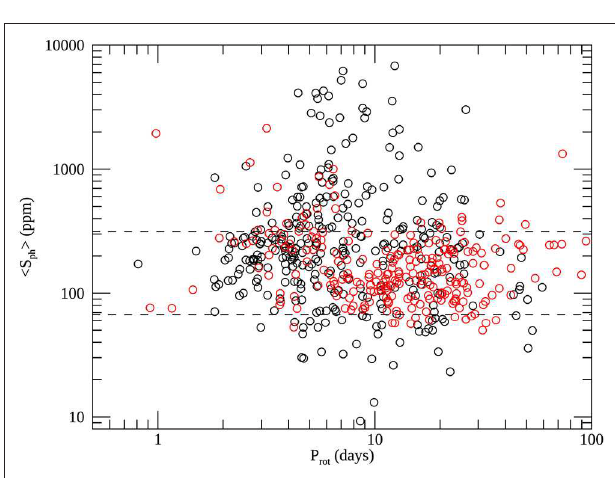
FIGURE 9 | Proxy of the magnetic activity, < S ph > as a function of the rotation period P rot for the full sample. The black symbols represent the non-oscillating stars while the red symbols represent the stars with detected oscillations from García et al. (2014a). The dash lines are the < S ph > values at minimum and maximum activity of the Sun.